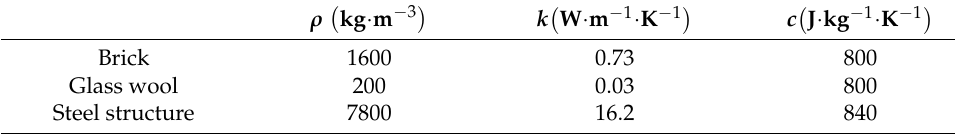
Table 2. The properties of the used materials